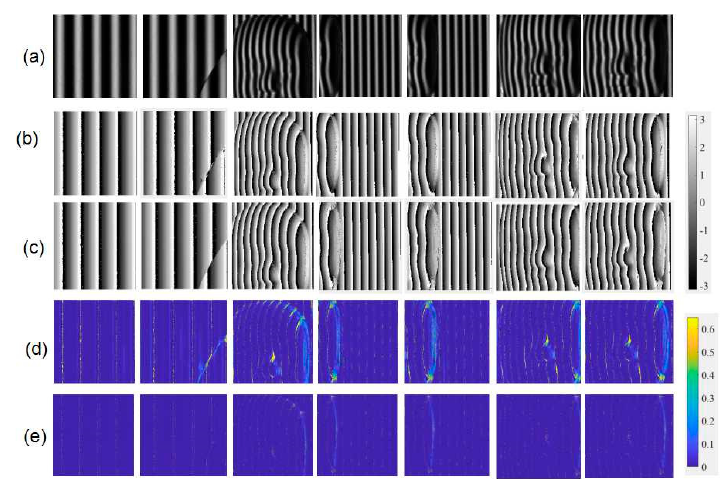
Figure 12. ( a ) Experimental fringe patterns, wrapped phase maps calculated from ( b ) four-step phase-shifting method, and ( c ) neural network, and corresponding error maps from ( d ) wavelet transform method, and ( e ) neural network.